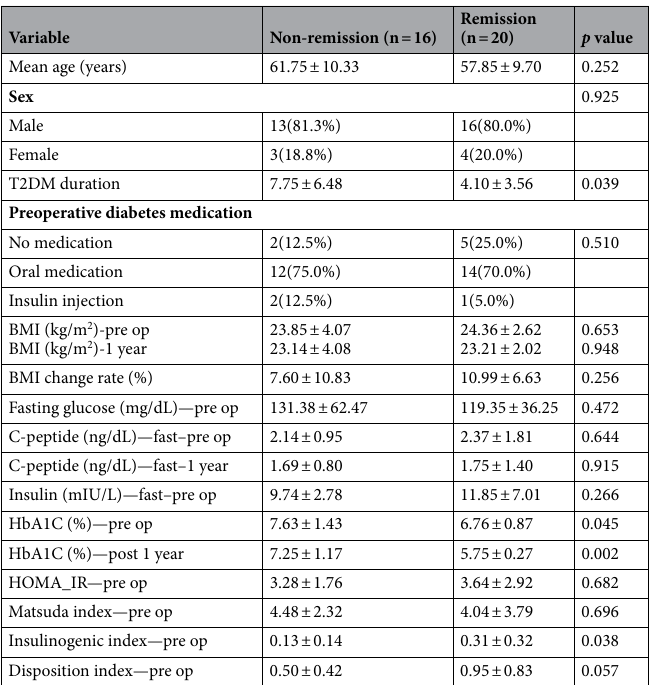
Table 2. Clinical characteristics of patients included in the subtotal gastrectomy with long-limb Roux- en-Y bypass group (non-remission vs. remission). T2DM Type 2 Diabetes Mellitus, BMI Body mass index, HOMA-IR Homeostatic model assessment of insulin